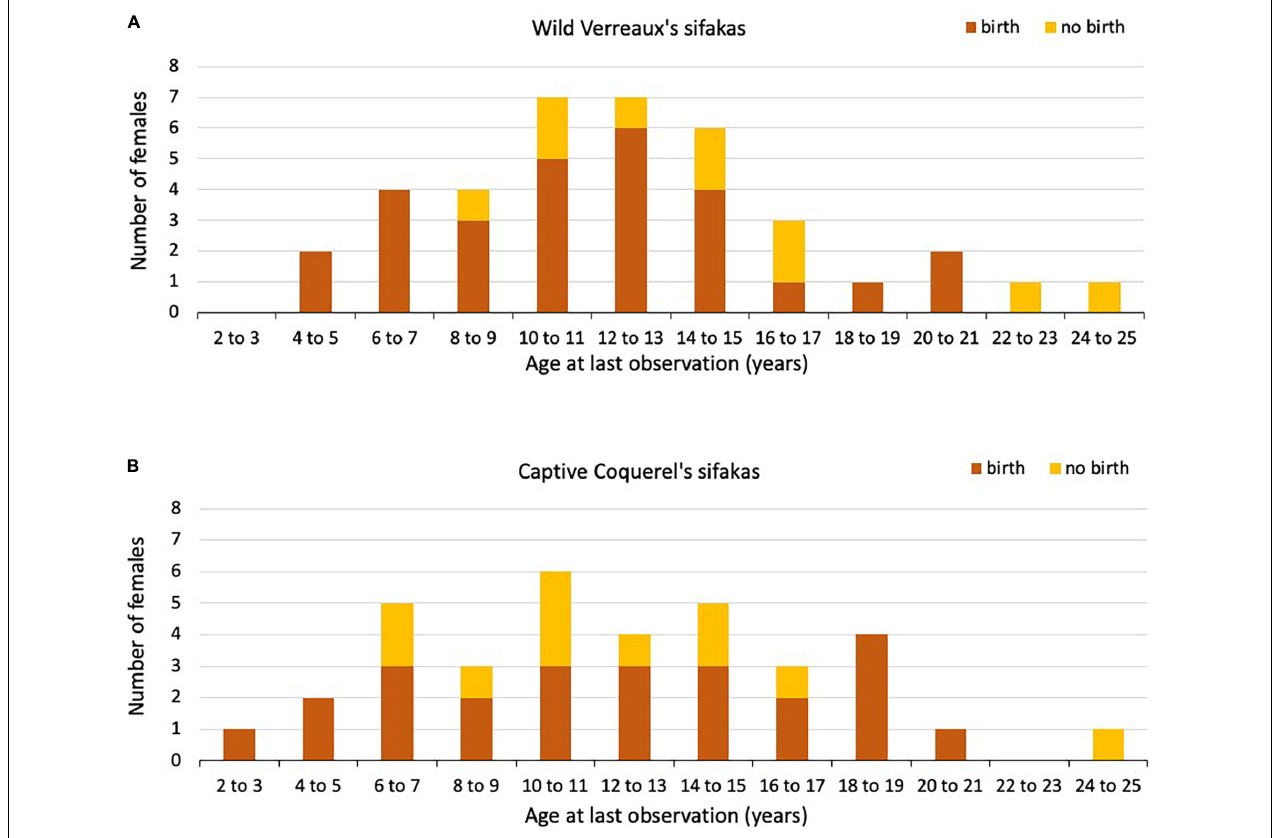
FIGURE 2 | Number of (A) wild Verreaux’s sifaka and (B) captive Coquerel’s sifaka females that gave birth (orange) or not (yellow) in their last year of life or observation (age in years). ( Figure 4C and Table 4 ). The model on the probability of giving birth in red lemurs including age revealed a better fit than the one including age and quadratic age (AIC: age = 330. age and quadratic age = 354). We found an effect of female’s age but not of longevity on the probability of giving birth, with older females being less likely to give birth ( Figure 4B and Table 6 ). of reproductive